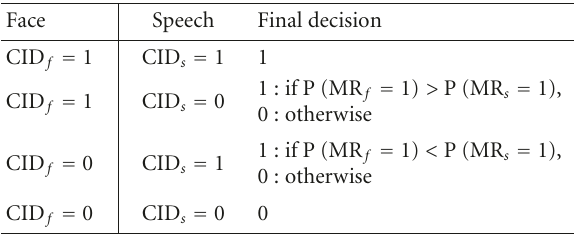
Table 1: Decision table for multimodal decision